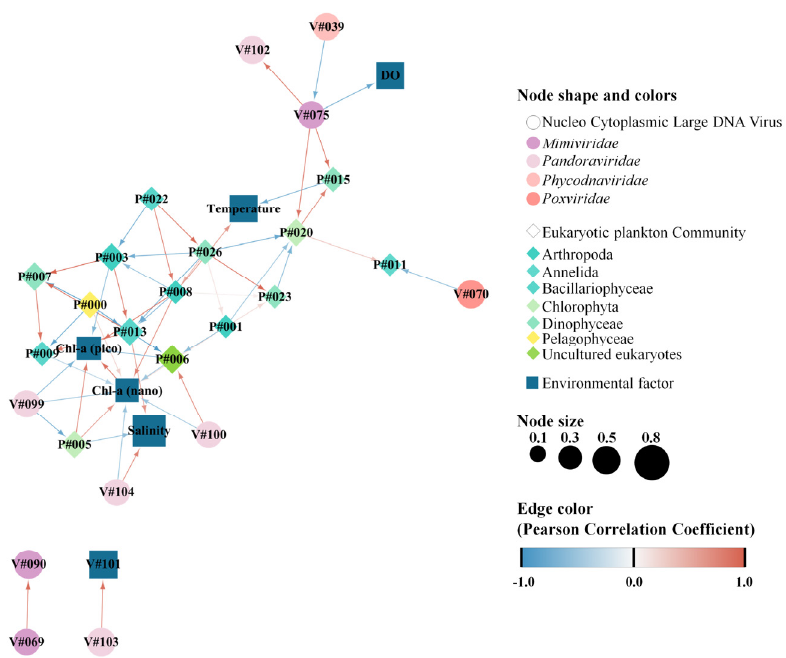
Figure 7. Network analysis showing the co–occurrence between common nucleocytoplasmic large DNA viruses (NCLDVs) and the eukaryotic plankton community (EPC), represented as blue and beige nodes, respectively. Lines between nodes indicate positive (blue) and negative (red) PCC correlation > |0.5| (two–sided pseudo p –value < 0.05) between the abundances of linked taxa. Detailed information (species names of operational taxonomic unit [OTU] numbers and correlation coefficients) is described in Table S7. 4. Discussion NCLDVs infect numerous autotrophs, including haptophytes, chlorophytes, and pelagophytes [5,57]. The current study aimed to elucidate how the NCLDV community changes with the increasing diversity and abundance of the EPC. We found that a variety of NCLDVs had co ‐ occurrence with a ubiquitous host or that an NCLDV was significantly correlated with various hosts. The findings of the current study provide novel insights to help elucidate the significant relationships and ecological processes that exist between NCLDVs and EPCs in the context of ecological emergence, and how NCLDVs contribute to ecological functions in the sub ‐ Arctic Kongsfjorden. The NMDS analysis showed apparent differences in each NCLDV and EPC composition between early white night and mid ‐ summer. These changes occurred according to environmental changes, namely warm water temperature influx and increased light intensity. Endo et al. [9] reported that NCLDV families correlate with specific eukaryotes and infect many eukaryotic lineages. Herein, Mimiviridae viruses were the most commonly detected compared to other NCLDV families, which agrees with the results of a previous study [57]. This is likely due to the diversity of Mimiviridae structure and, a subsequent, broad range of hosts and environments compared to the reference sequences of known viral genomes [58]. In particular, Mimiviridae species are frequently found in low ‐ temperature seawater, such as in the Arctic [59,60], which is likely related to the frequency and types of hosts. Indeed, our results showed that Mimiviridae and Pandoraviridae were significantly and positively correlated with specific EPC taxa, namely, Aureococcus anophagefferens (pOTU#0) increased rapidly in June, as did Megavirus chiliensis (vOTU#69) and Chrysochromulina ericina virus (vOTU#26) also increased. Chrysochromulina ericina virus was predicted to be an abundant viral group as it readily infects microalga (the haptophyceae Haptolina ericina , formerly Chrysochromulina ericina) that are